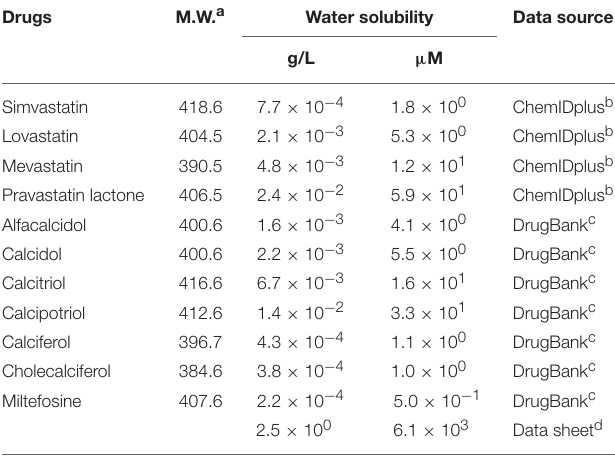
TABLE 1 | Expected values for water solubility of drugs examined in this